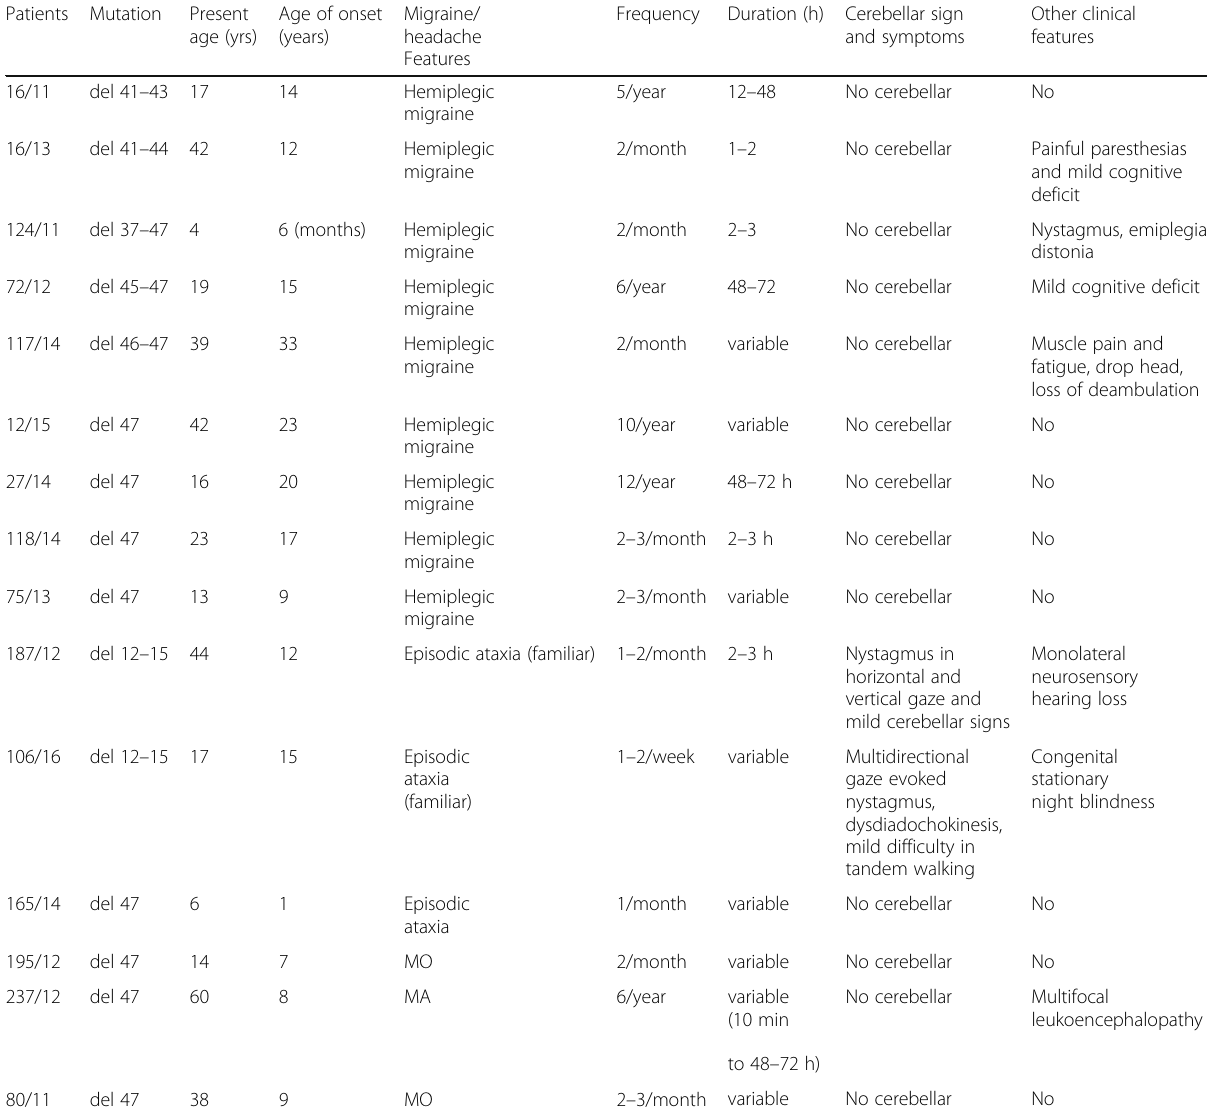
Table 3 Clinical Features Patients